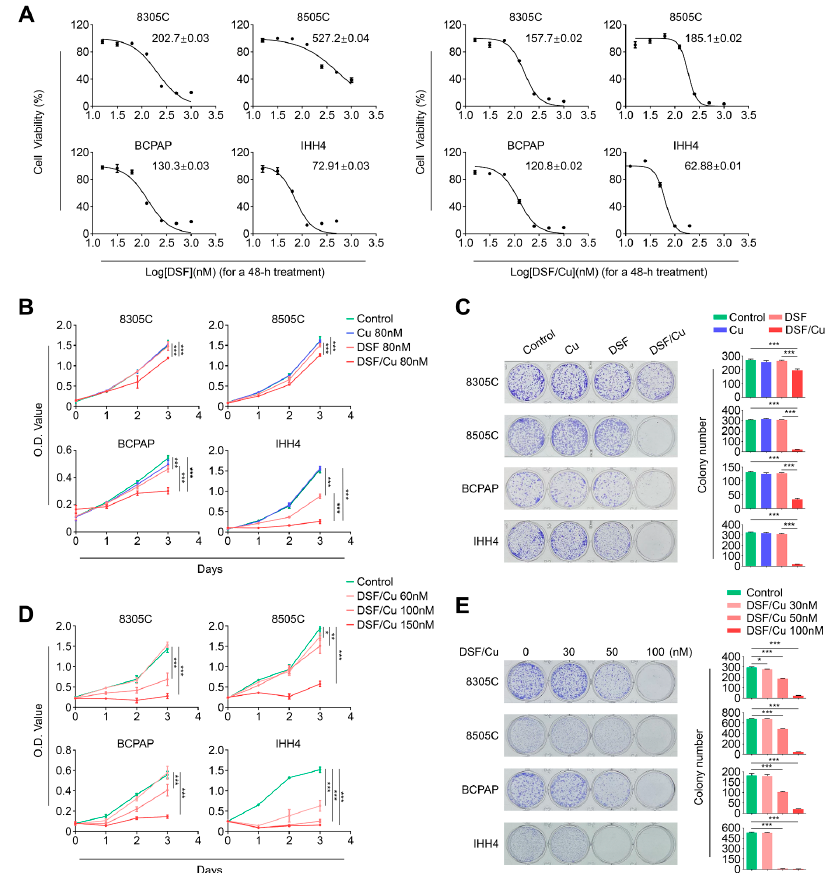
Figure 1. Copper (Cu) enhances the antitumor activity of disulfiram in BRAF V600E -mutated thyroid cancer cells. ( A ) BRAF V600E -mutated thyroid cancer cell lines 8305C, 8505C, BCPAP and IHH4 were treated with different concentrations of DSF or DSF/Cu (at 1:1 molar ratio) for 48 h. Cell viability was evaluated by MTT assay, and half-maximal inhibitory concentration (IC50) values were then calculated using the Reed–Muench method. ( B ) The above cells were treated with 80 nM DSF and 80 nM CuCl 2 , individually or in combination, for the indicated times. MTT assay was then performed to assess the proliferation of these cells. ( C ) Cells were treated with the indicated concentrations of DSF and CuCl 2 , individually or in combination (8305C: 80 nM DSF and/or 80 nM CuCl 2 ; 8505C: 120 nM DSF and/or 120 nM CuCl 2 ; BCPAP: 100 nM DSF and/or 100 nM CuCl 2 ; IHH4: 50 nM DSF and/or 50 nM CuCl 2 ) for 9 days, and then stained with crystal violet. The left panels show the representative images of colony formation. Quantitative analysis of colony numbers are presented in the right panels. ( D ) Cells were treated with different doses of DSF/Cu for the indicated times. MTT assay was then performed to evaluate their effects on cell viability. ( E ) Colony formation assay was performed when these cells were treated with DSF/Cu in dose-dependent manner for 9 days (left panels). Quantitative analysis of colony numbers is presented in the right panels. Data presented as means ± SD. * p < 0.05; ** p < 0.01; *** p <